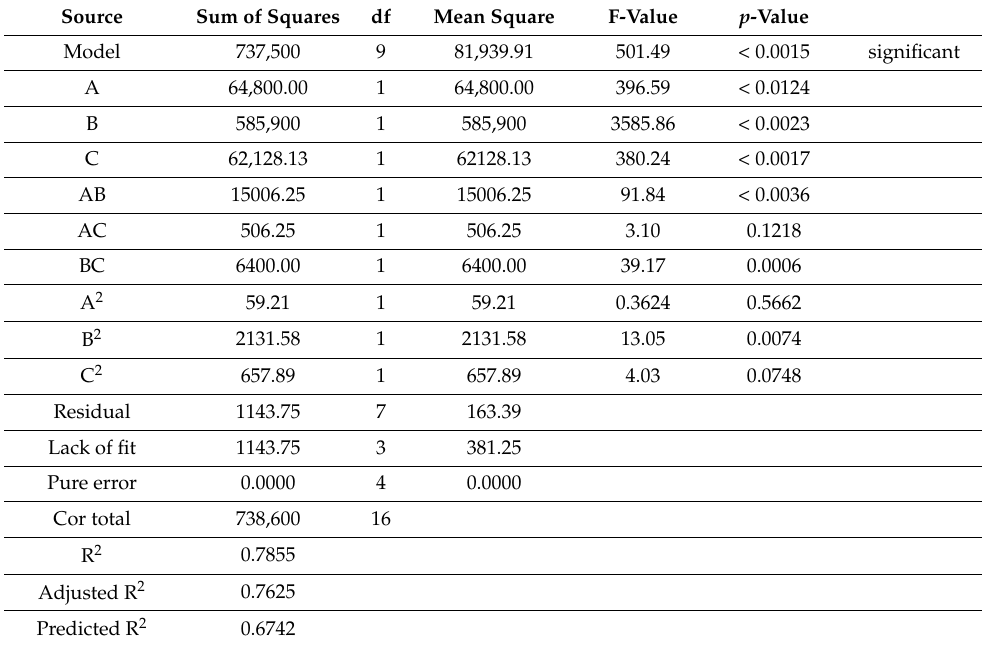
Table 8. ANOVA quadratic model for modal